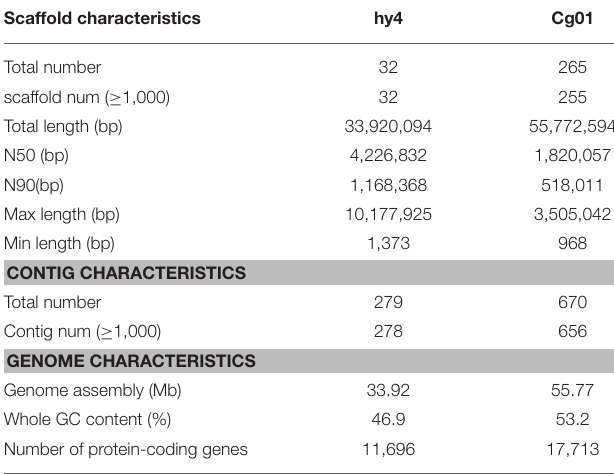
TABLE 1 | Genomic information for the two HupA-producing endophytes P. polonicum hy4 and C. gloeosporioides Cg01. Scaffold